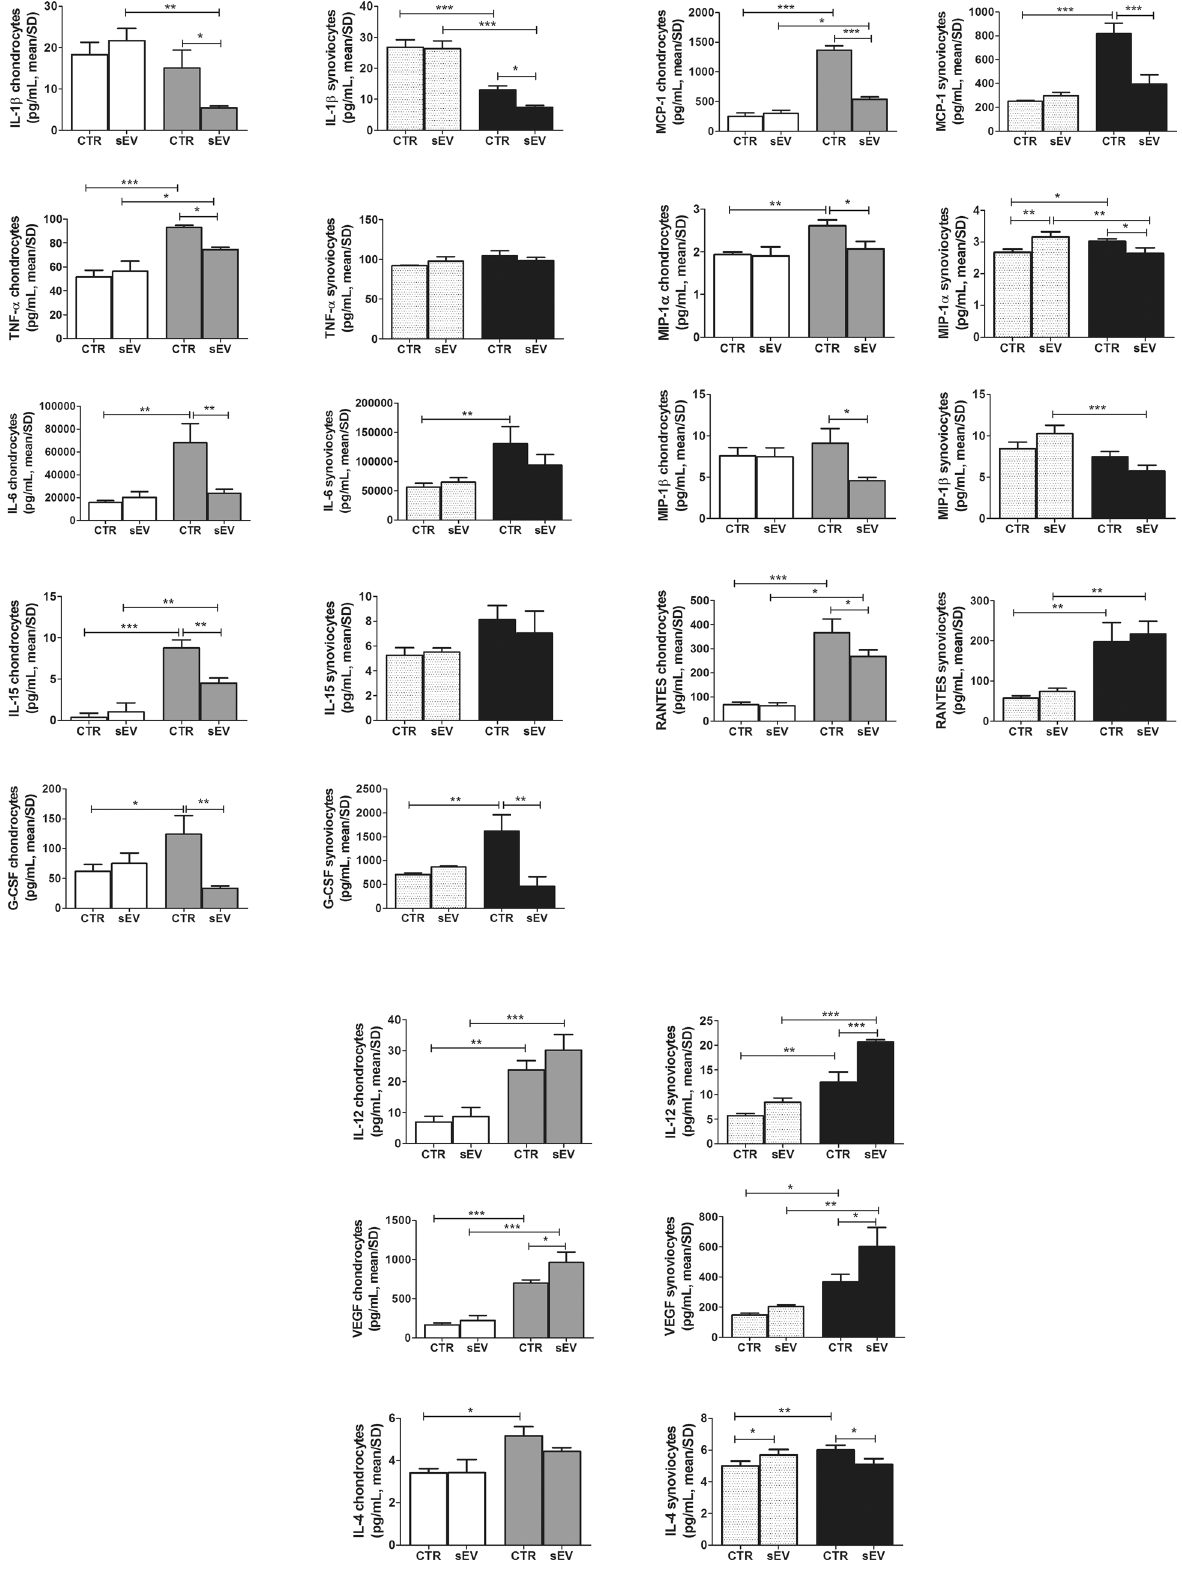
Figure 4. sEV effects on Cytokines/Chemokines protein release. Each graph reports data collected from 3 independent sEV samples and expressed as means ± SD. Data were compared by ANOVA, followed by